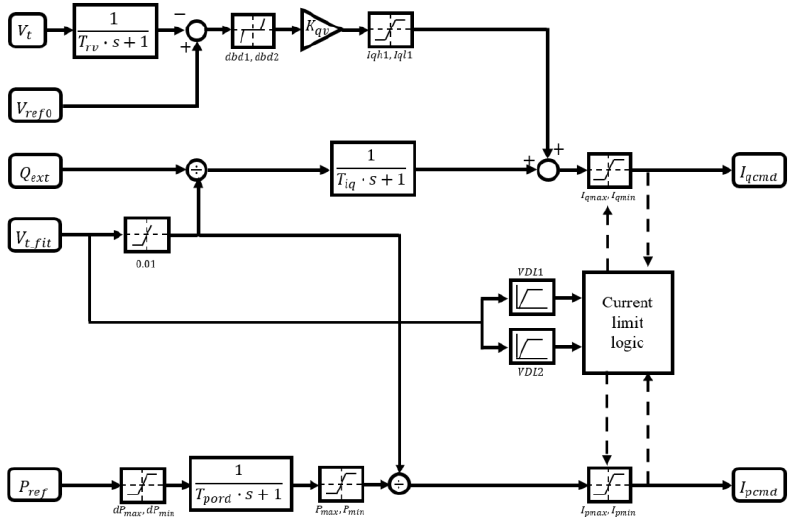
Figure 8. The simplified universal model of the WECC energy storage system — REEC module .